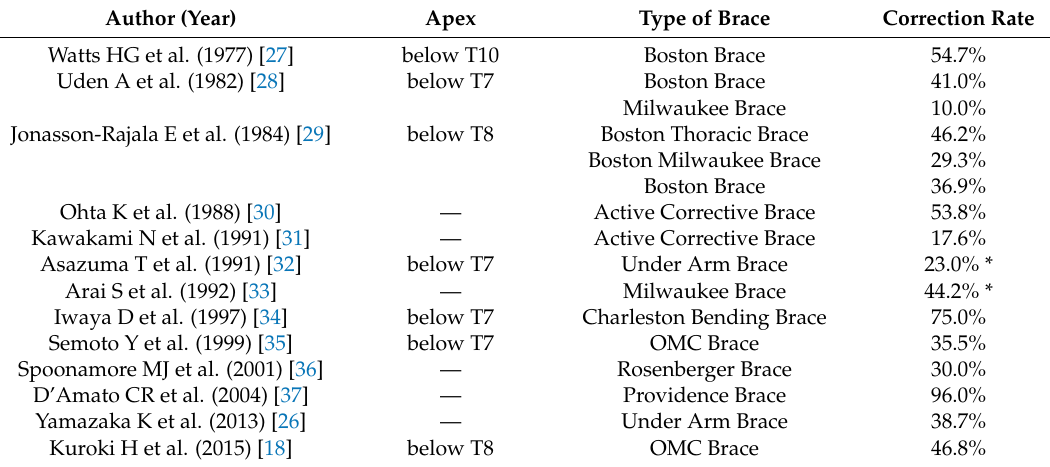
Table 2. Literature review of the initial correction